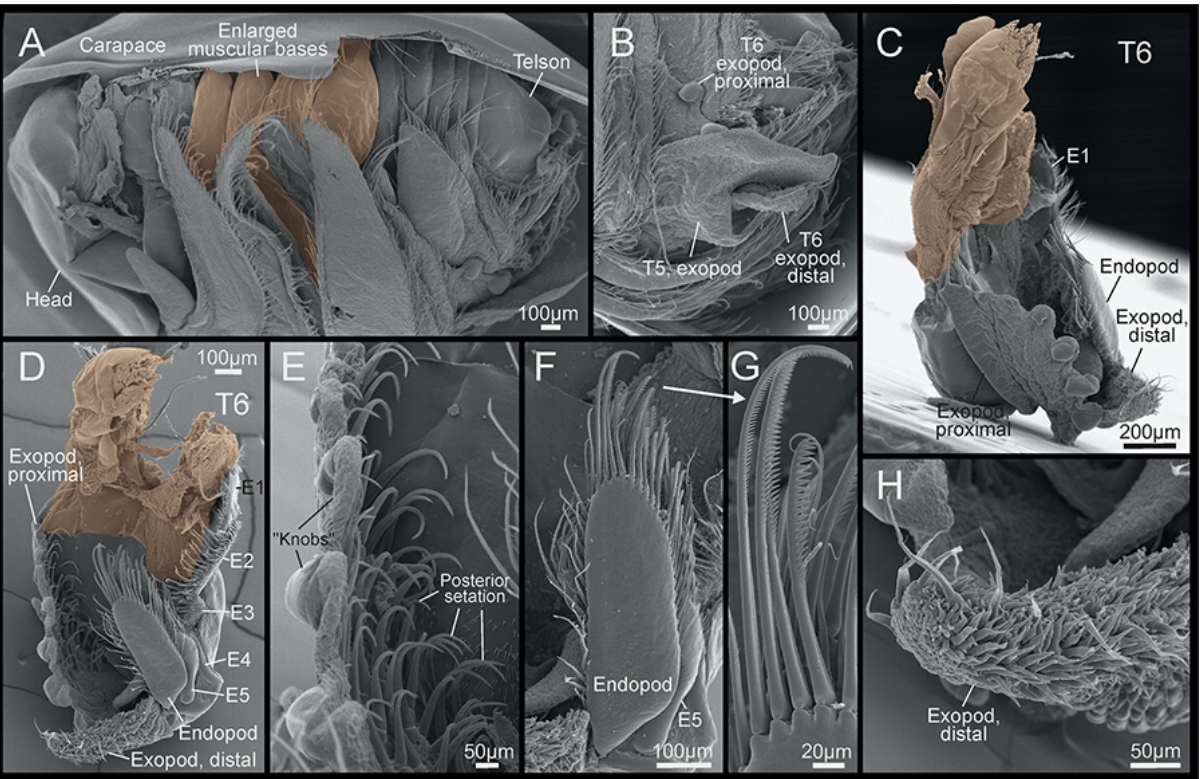
Figure 7. Lynceus grossipedia n. sp., male, scanning electron microscopy of modified thoracopods, broad muscular bases highlighted by coloring (same specimen as on Figs. 4, 6; paratype, NHMD-616086). A. Dorsolateral view of thoracopods, broad muscular bases of thoracopods III–VI colored. B. Modified exopods of thoracopod V and VI. C–H: all of thoracopod VI. C. Thoracopod VI in posterolateral view, note exopod with ~7 knob-shaped processes. D. Thoracopod VI in posterior view with endites, endopod and exopod labelled. E. Exopod, knob-shaped processes and posterior surface with long setae (magnification of D). F. Endopod, broadly lobiform (magnification of D). G. Setae of endopod (magnification of F). Distal part of exopod densely